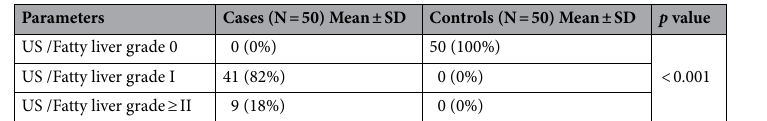
Table 1. Baseline and Laboratory characteristics of studied groups. HOMA-IR homeostasis model assessment of insulin resistance.